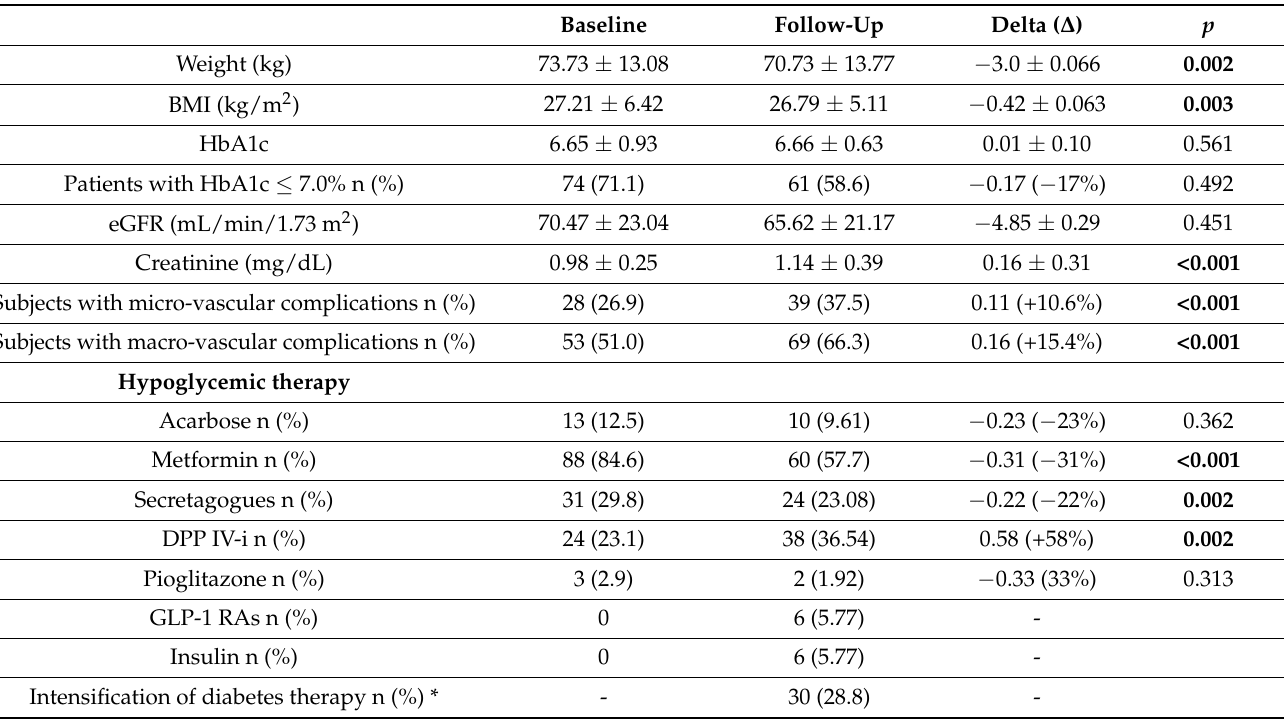
Table 3. Variation of clinical characteristics of T2D elderly subjects participating in the study, after 6 years of follow-up Metabolic control and hypoglycemic therapy in T2D elderly subjects participating to the study, after the 6 years-observation